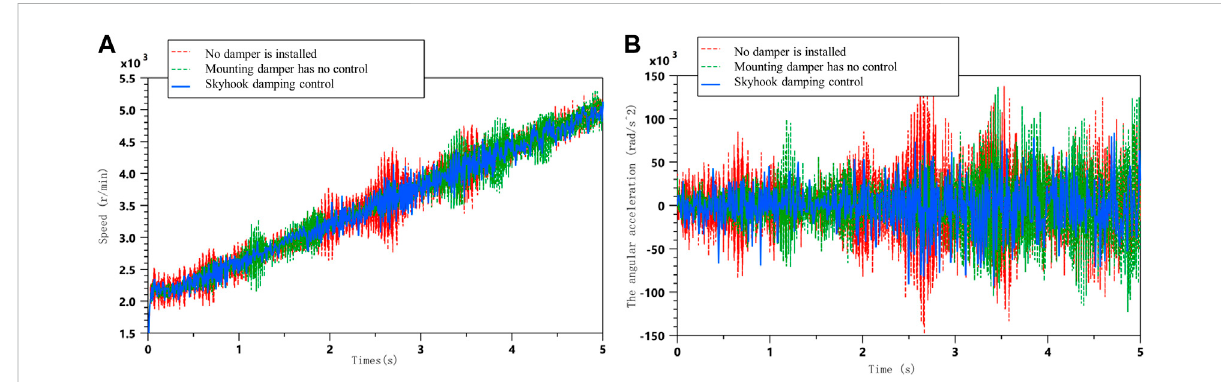
FIGURE 13 Comparison of simulation results for acceleration conditions; (A) Comparison of free end speeds of crankshaft systems under acceleration conditions; (B) Comparison of angular acceleration at the free end of the crankshaft system under acceleration conditions.